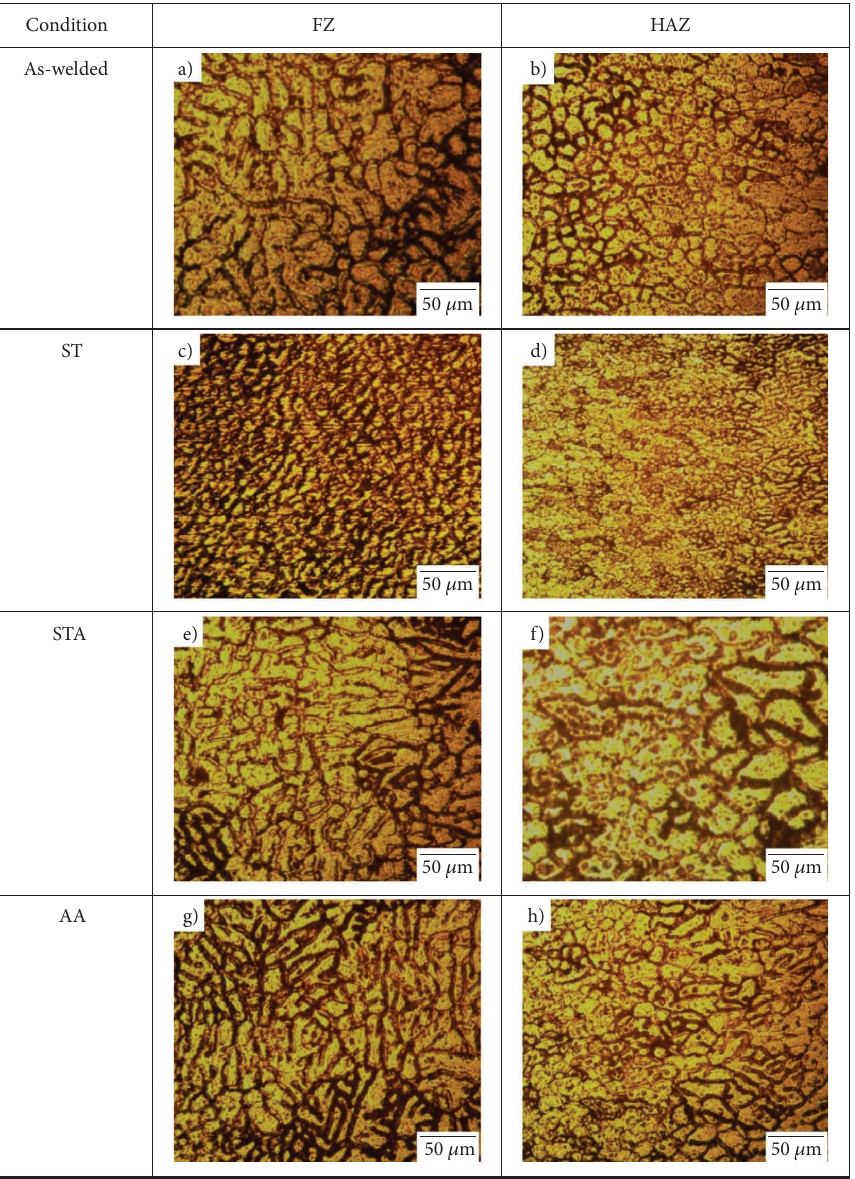
Figure 7: Optical micrographs of joints of AA2014-T6 alloy: (a), (c), (e), and (d) FZ of as-welded, ST, STA, and AA joints; (b), (d), (f), and (h) HAZ of as-welded, ST, STA, and AA